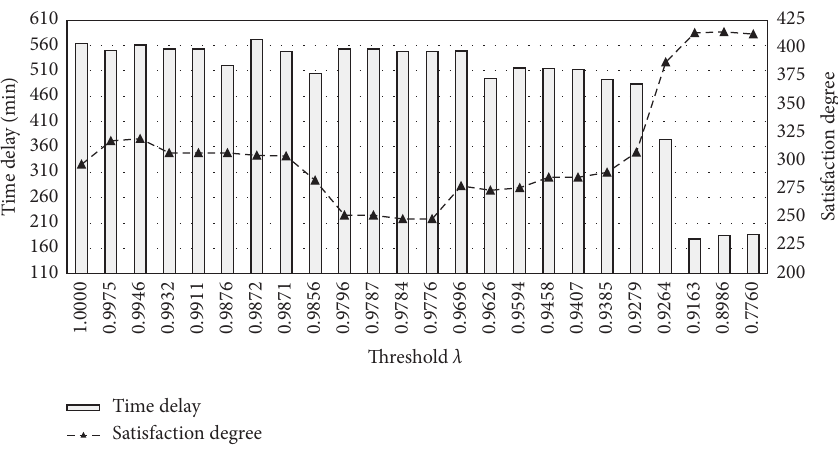
Figure 15: The adequate solutions of M.2 under each clustering hierarchy. Table 5: The adequate solution under each threshold λ ≤ 0 .